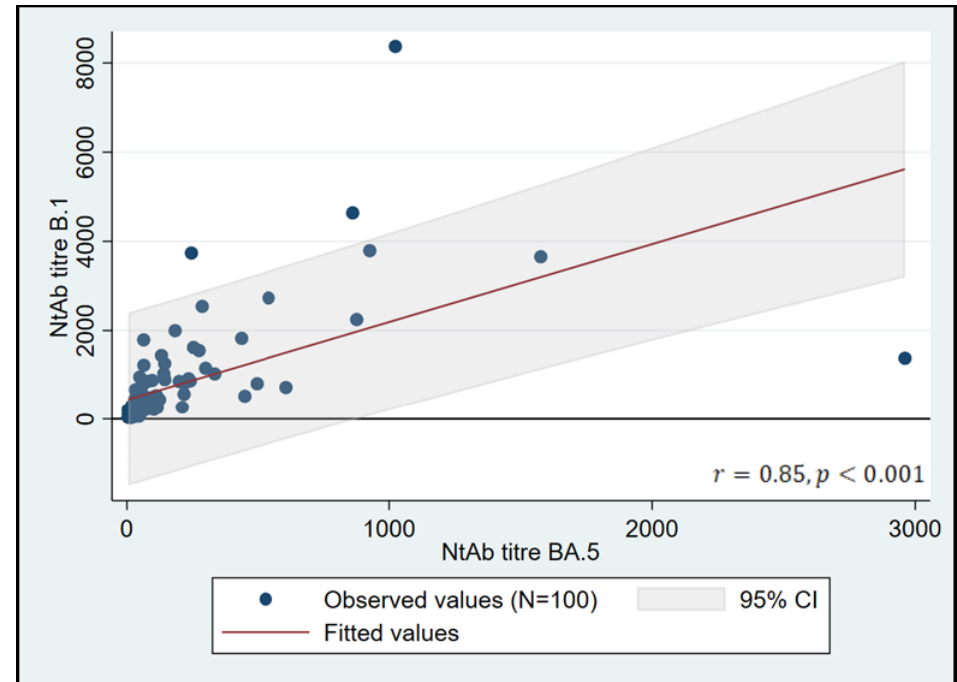
Figure 1. Linear regression between B.1 titers and BA.5 titers in HIV patients 6 months after the third BNT162b2 vaccine dose (entire cohort). NtAb titers are expressed as ID 50 , which is the reciprocal value of the sera dilution and shows 50% protection from the virus-induced cytopathic effect.